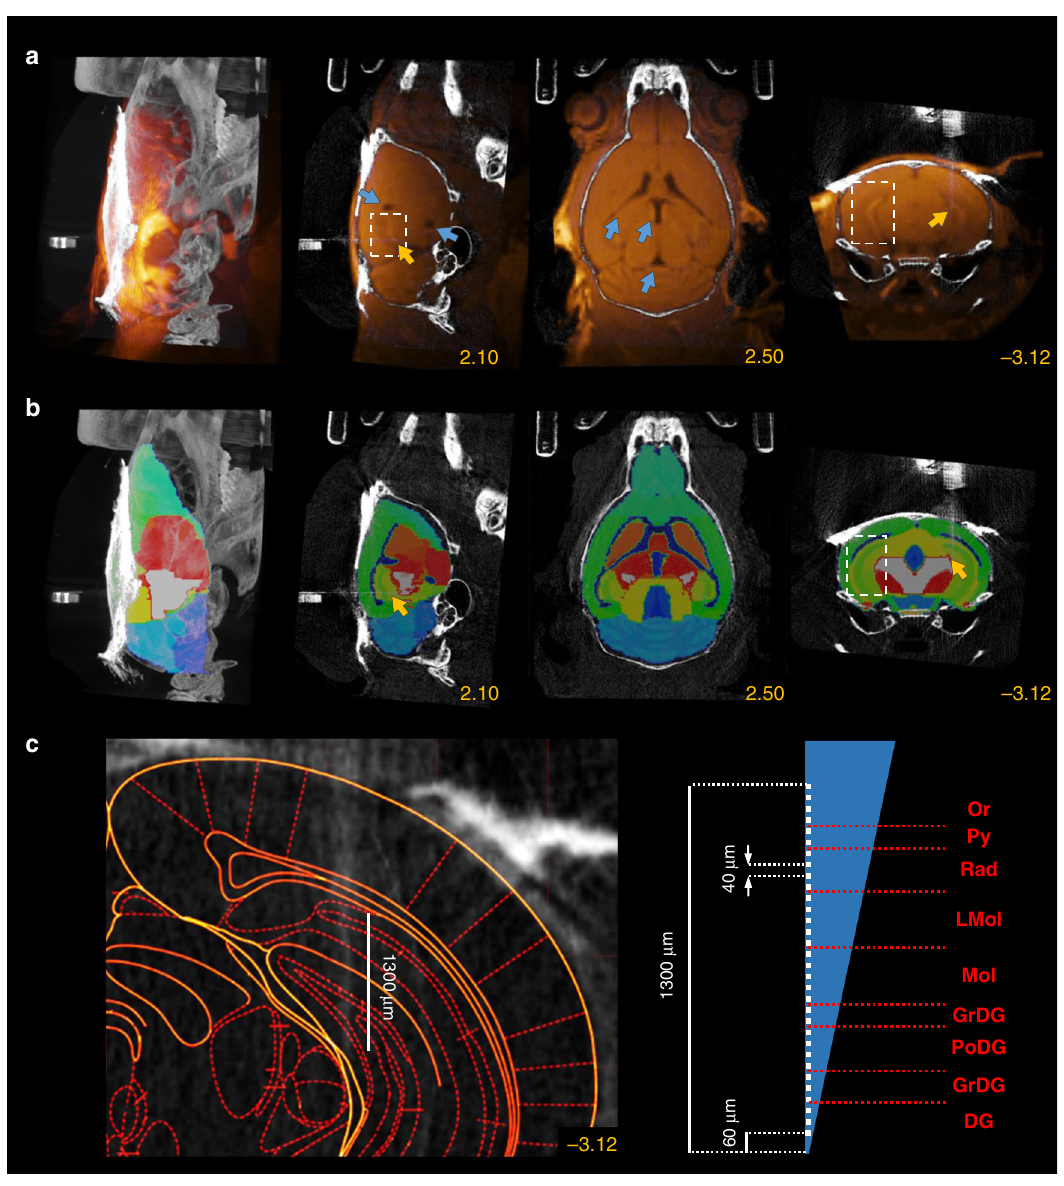
Fig. 5 Localization of hippocampal implants with 3T MRI imaging. a The postoperative CT image co-registered with the high signal-to-noise ratio (SNR) T 1 -weighted preoperative MRI image shows the hippocampus (white dashed box) in addition to the ventricles (blue arrows). The yellow arrow shows the position of an edge silicon probe in the hippocampus. Images from left to right, maximum intensity projection, sagittal slice, horizontal slice, and coronal slice. Yellow numbers refer to the corresponding stereotaxic coordinates in mm relative to Bregma. b Three-dimensional atlas co-registered with the postoperative CT image using the CT – MRI fusion technique with special attention to the alignment of the hippocampal structure. c Left, localized trajectory of the probe in the hippocampus. Right, layer-speci fi c reconstruction of 32 contact sites (Or oriens layer, Py pyramidal layer, Rad stratum radiatum, LMol lacunosum moleculare, Mol molecular layer, GrDG granular layer, PoDG polymorph layer, DG dentate gyrus). CT and MRI images are shown in grayscale and goldscale,